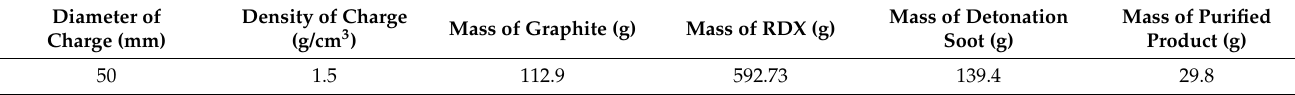
Table 1. Particle number comparison experimental scheme and results. Diameter of Charge (mm)